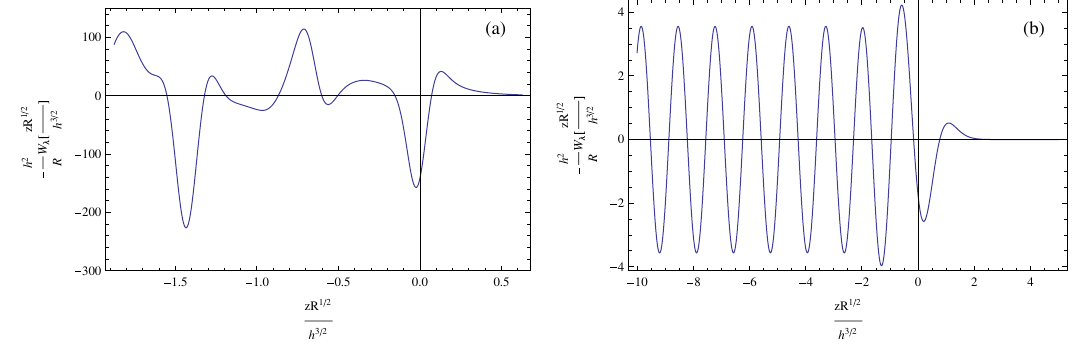
FIG. 5 (color online). Bunch wake as a function of the dimensionless position ˆ z for (a) χ ¼ 0 . 0625 and (b) χ ¼ 0 . 5 when a single mode is dominant. Note that there is a factor of 20 reduction resulting from the larger shielding